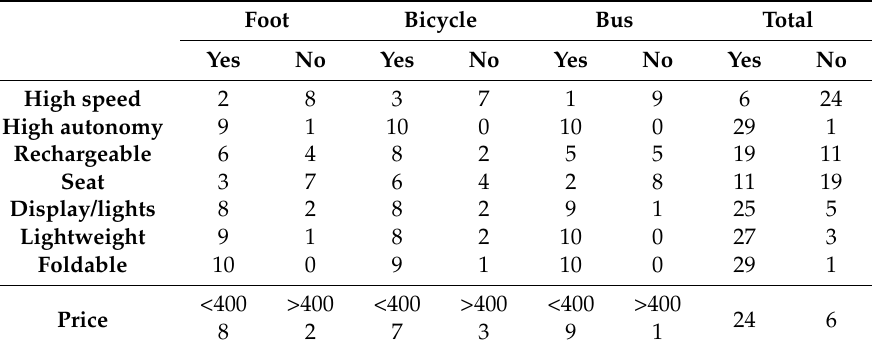
Table 4. Survey Results.